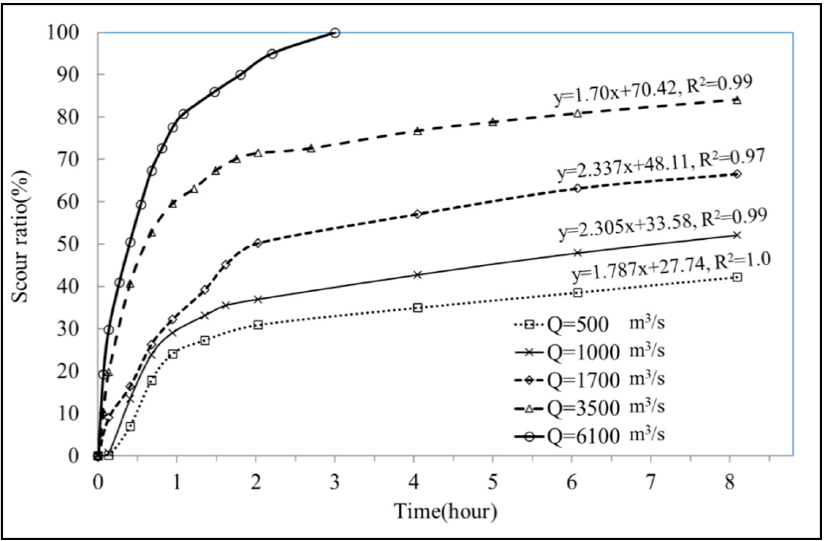
Figure 11. Trend of the scour ratio against time for sediment with the water content of 40% at various reservoir flood discharges. Table 2. Scour ratio, experimental duration, and estimated duration for achieving a scour ratio of 100% for each given discharge at di ff erent water